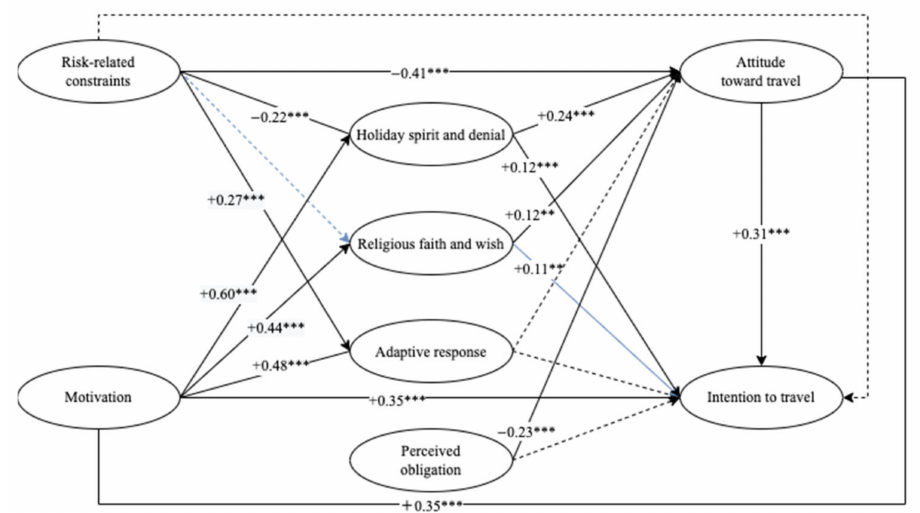
Figure 2. Results of hypothesis model (Round 1). Note: ** p < 0.05, *** p < 0.01.